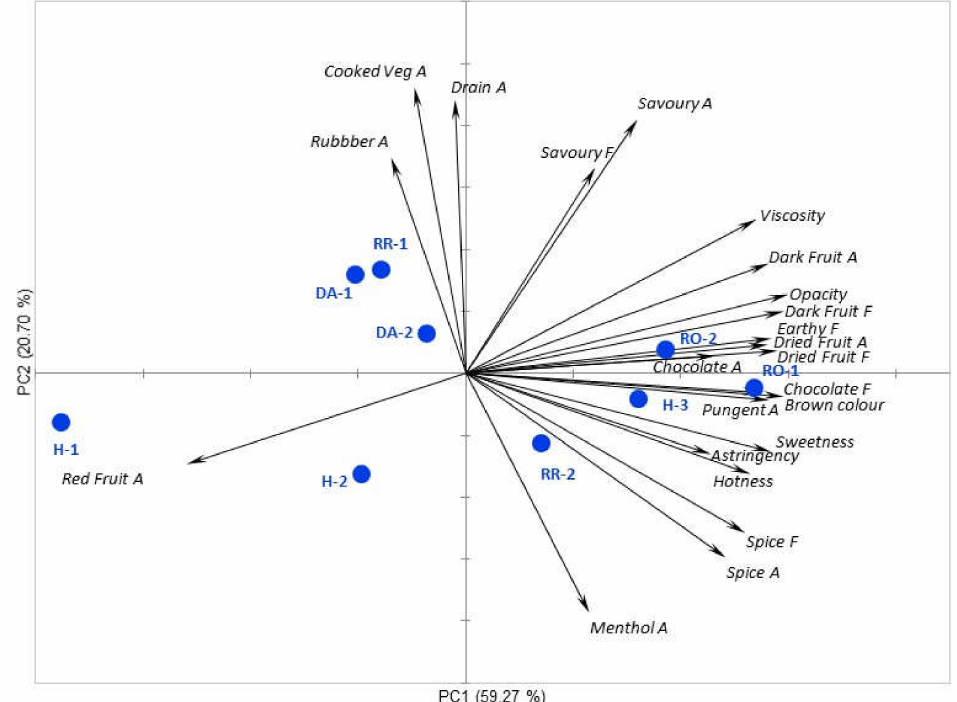
Figure 1. Principal component biplot of significant ( p < 0.05) and close to significant sensory attributes ( p < 0.10) for the harvest time and water addition winemaking treatments determined in Shiraz wines at 12 months post-fermentation. A: Aroma, F: Flavour, H-1, H-2, H-3 = harvest-1, harvest-2 and harvest-3; DA-1, DA-2 = direct water addition treatment 1 and direct water addition treatment 2; RR-1, RR-2 = juice substitution treatment-1, juice substitution treatment 2; RO-1, RO-2 = saigne é treatment 1 and saigne é treatment